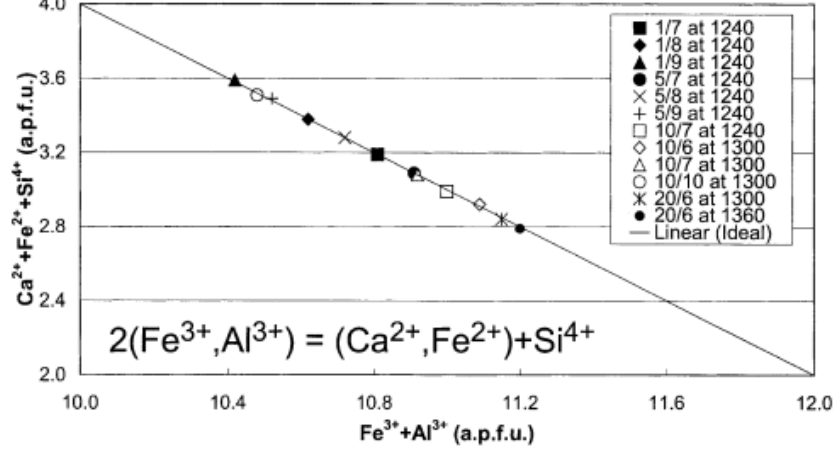
Figure 8. Plot of Ca 2+ + Fe 2+ + Si 4+ (a.p.f.u.) vs. Fe 3+ + Al 3+ (a.p.f.u.) for various SFCA compositions [62].